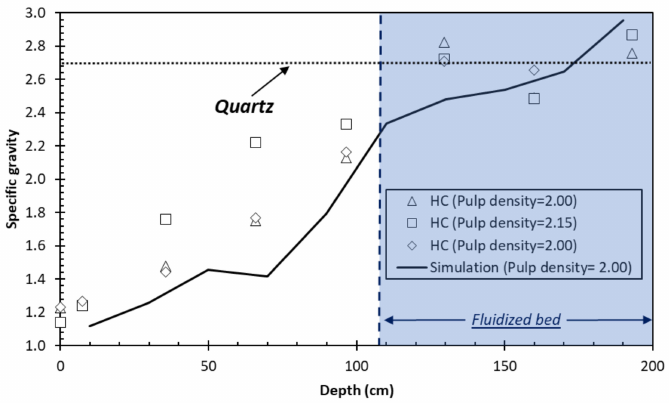
Figure 8. Experimental and simulated slurry pulp density as a function of